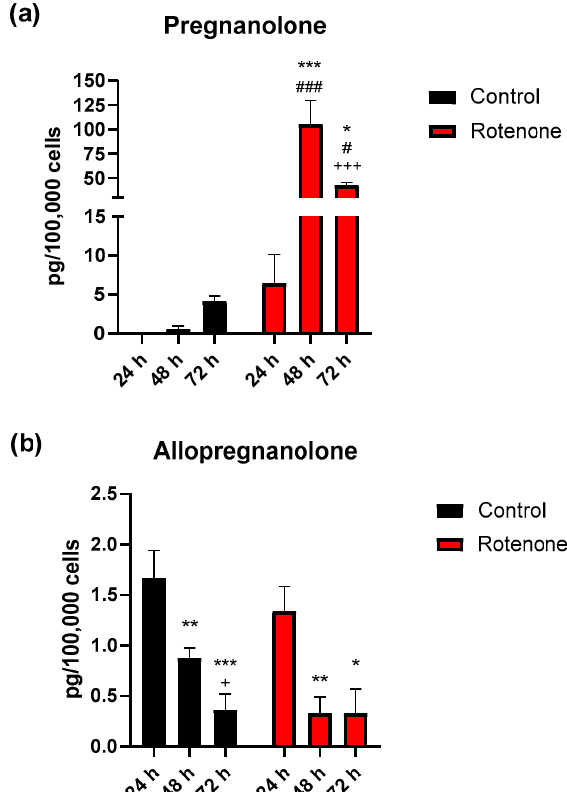
Figure 6. Pregnanolone ( a ) and allopregnanolone ( b ) concentration in BV-2 cells medium determined by LC-MS / MS in microglia, in resting condition (Control) or after activation by exposure to rotenone at di ff erent time intervals (24, 48 and 72 h). The data represent the average of 2 independent experiments ( n = 5) and are expressed in pg / 100,000 cells (mean values ± SEM). The significance of the di ff erences was determined by two-way ANOVA followed by Holm-Š í d á k post-hoc test. Pregnanolone: *** p < 0.001, * p < 0.05, vs 24 h rotenone; +++ p < 0.001, vs 48 h rotenone; ### p < 0.001, # p < 0.05, vs same time interval of control. Allopregnanolone: *** p < 0.001, ** p < 0.01, vs 24 h control or rotenone; * p <